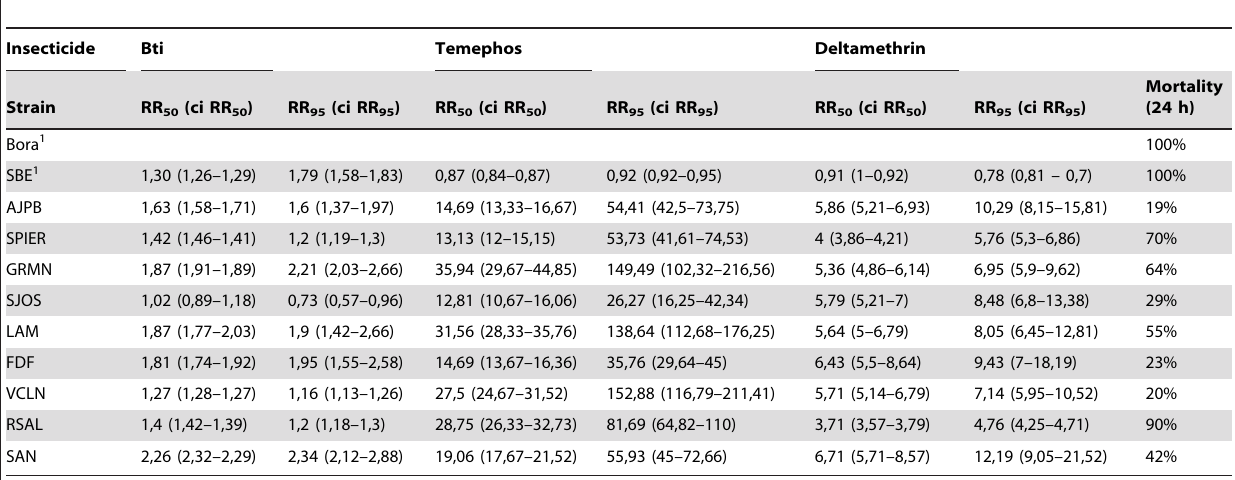
Table 1. Resistance status of Aedes aegypti populations of Martinique to Bti , temephos (larvae) and deltamethrin (adults).